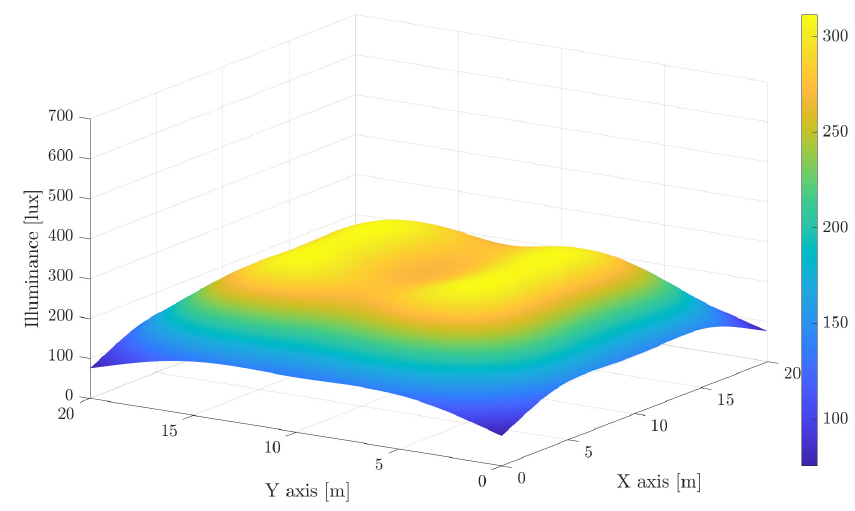
Figure 2. Illuminance in an indoor scenario. Beam angle of 50 ◦ .